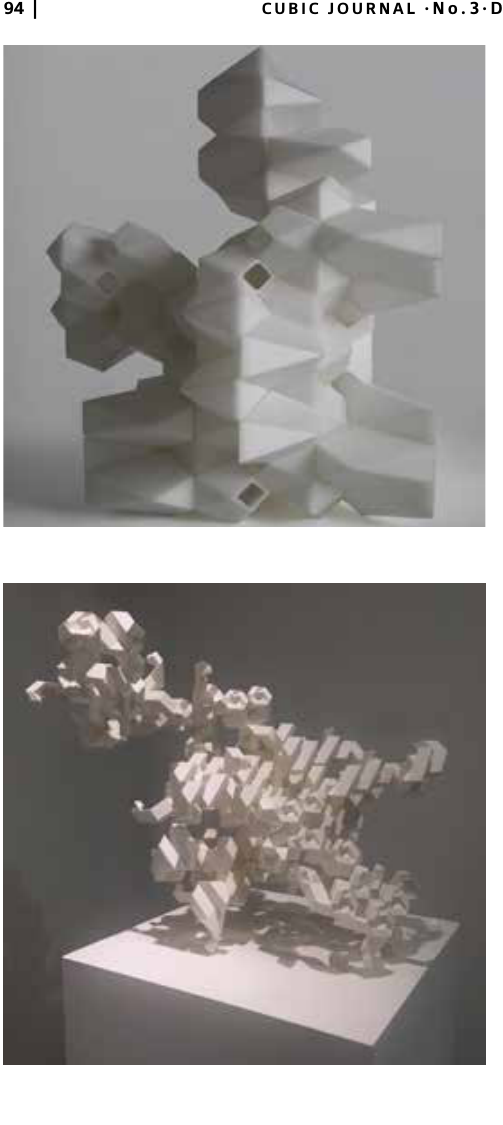
Figure 14 — 15 (top to bottom, page 93): Binary Table (2016). Stainless steel. 1.25m x 1.25m x 0.45m. Design : Daniel Widrig Studio. Source: author. Figure 16 —20 (this page and opposite): Brillock (2016). 3D printed PLA plastic, Wood .1.25m x 1.25m x 0.45m. Design : Daniel Widrig, Soomeen Hahm, Stefan Bassing, Igor Pantic. Team : Mayank Khemka, Huan Pu, Jianfeng Yin, Xiangyu Ren. Source: